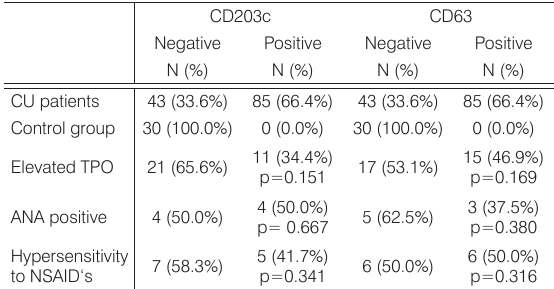
Table 1. CD203c, CD63 and other autoreactivity markers.